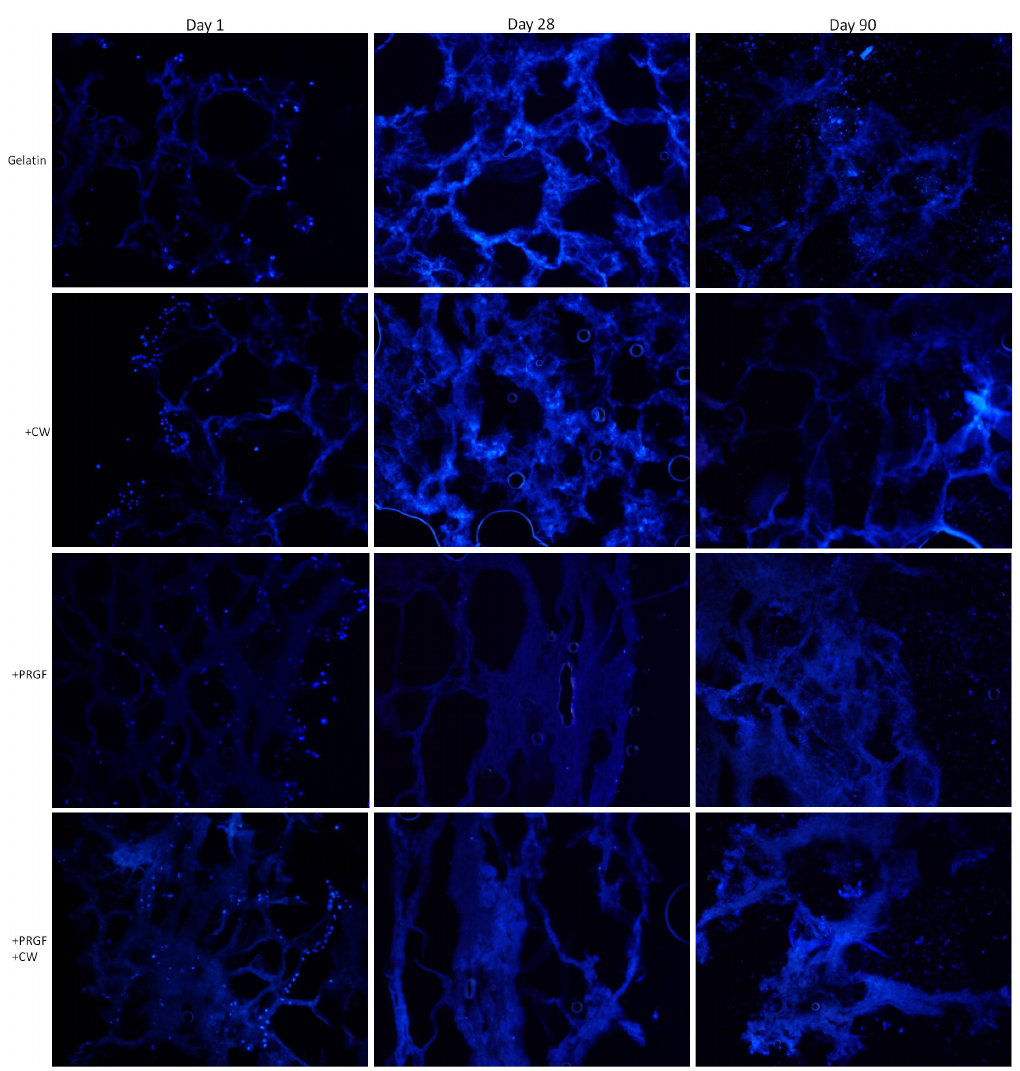
Figure 8. DAPI staining of +EDC cross-linked scaffolds with MG-63 cells for 1, 28, and 90 days. Images taken at 20×